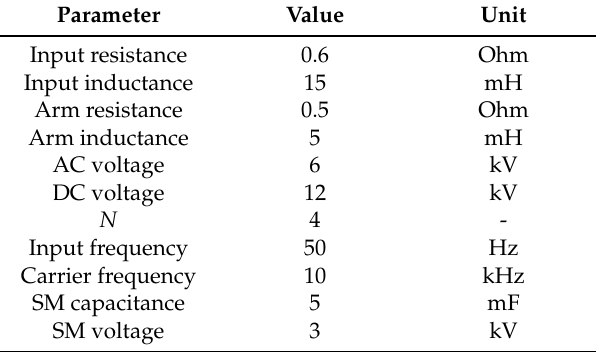
Table 1. Simulated system parameters. AC: alternating current; DC: direct current.